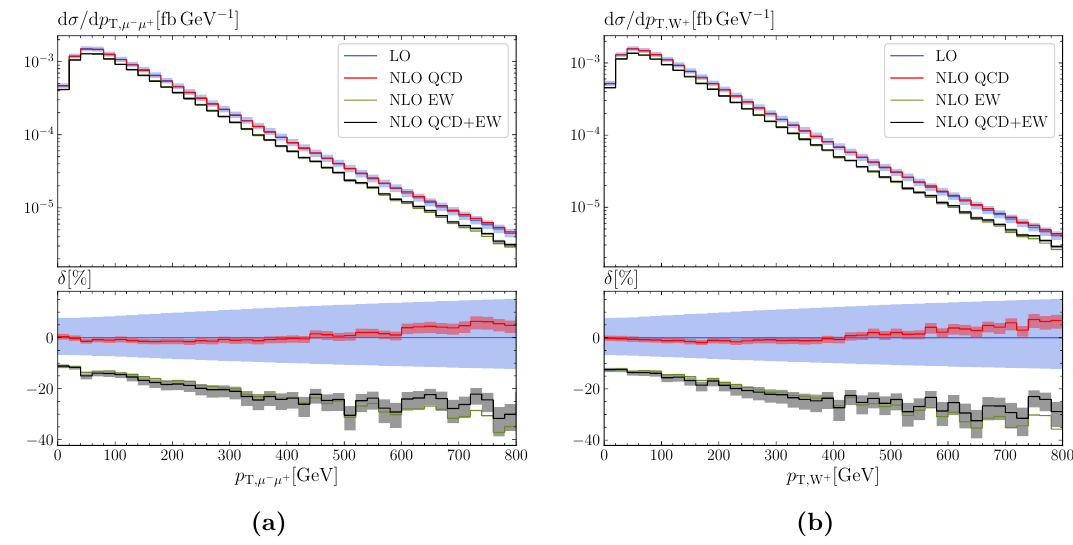
Figure 7. Di(cid:11)erential distributions for pp (a) transverse momentum of the muon-anti-muon system (left) and(b) transverse momentum of the reconstructed W boson (right). The upper panel shows the LO contributions of order two NLO predictions [including